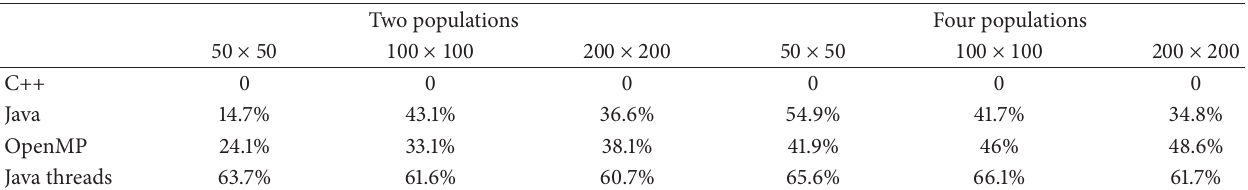
Table 4: Simulation results. The slowest technology has a score of 0. The other three technologies have a percentage according to how faster they were compared with the slowest